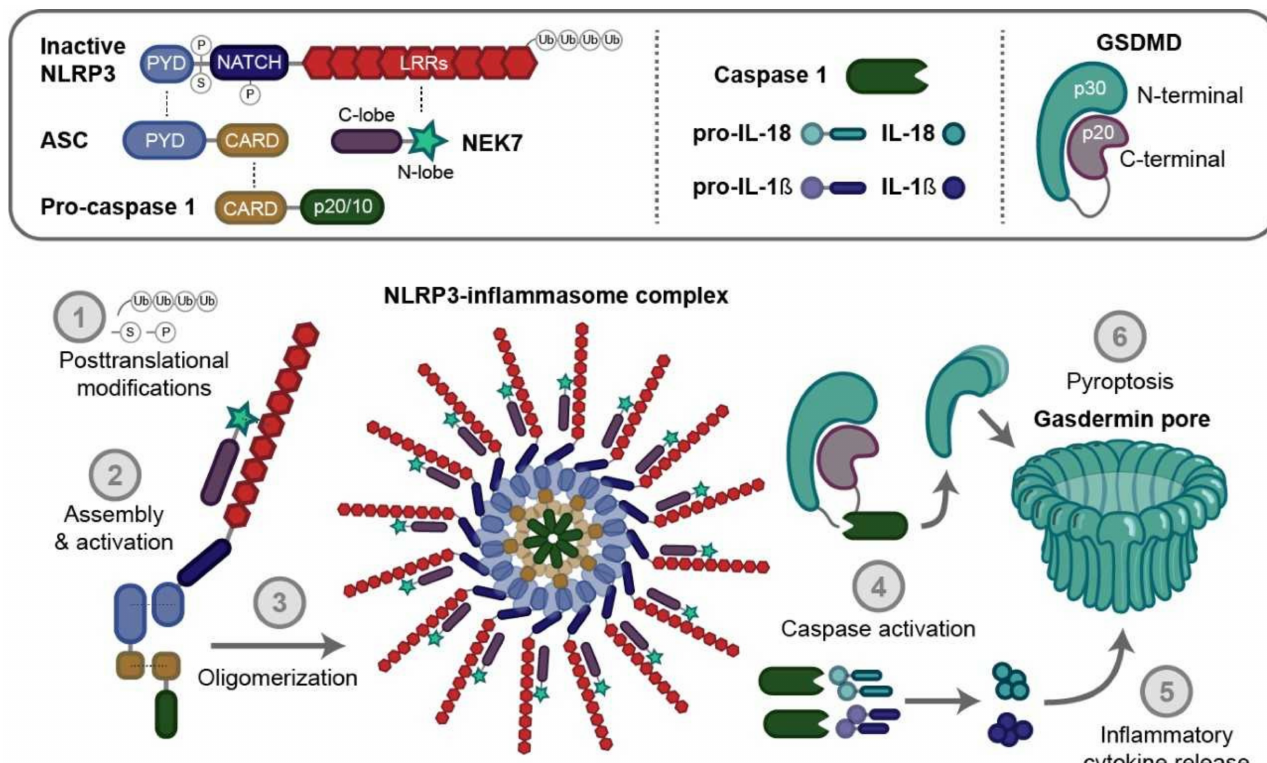
Figure 1. The nucleotide-binding oligomerization domain like receptor family (NOD-like) pyrin domain containing 3 (NLRP3) inflammasome complex. The NLRP3 inflammasome is a multiprotein complex regrouping several proteic actors. In basal conditions, NLRP3 is selfrepressed via an internal interaction between its NACHT and LRR domain. ‘S’, ‘P’, and ‘Ub’ symbols on the inactive form of NLRP3 mean SUMOylation (SUMO, Small Ubiquitin-like Modifier proteins), phosphorylation and ubiquitination, respectively. After its priming, several posttranslational modifications take place (1), leading to the removal of this interaction and the binding of NLRP3 to ASC protein, through its PYD domain, and to NEK7 via its LRR domain, and, thus, NLRP3 activation. In turn, procaspase-1 interacts with ASC through its CARD domain (2). Oligomerization (3) triggers the activation of caspase-1 (4) and the processing of pro-IL-1 β , pro-IL-18 and Gasdermin D (GSDMD) into their mature forms, thereby triggering inflammatory cytokines release (5) and pyroptosis (6). ASC, apoptosis associated speck like protein containing a caspase recruitment domain; CARD, caspase recruitment domain; LRR, leucine-rich repeats; NACHT, NAIP (neuronal apoptosis inhibitor protein), C2TA (MHC class 2 transcription activator), HET-E (incompatibility locus protein from Podospora anserina ) and TP1 (telomerase-associated protein) NLRP3, NOD-, LRR- and pyrin domain-containing protein 3; PYD, pyrin